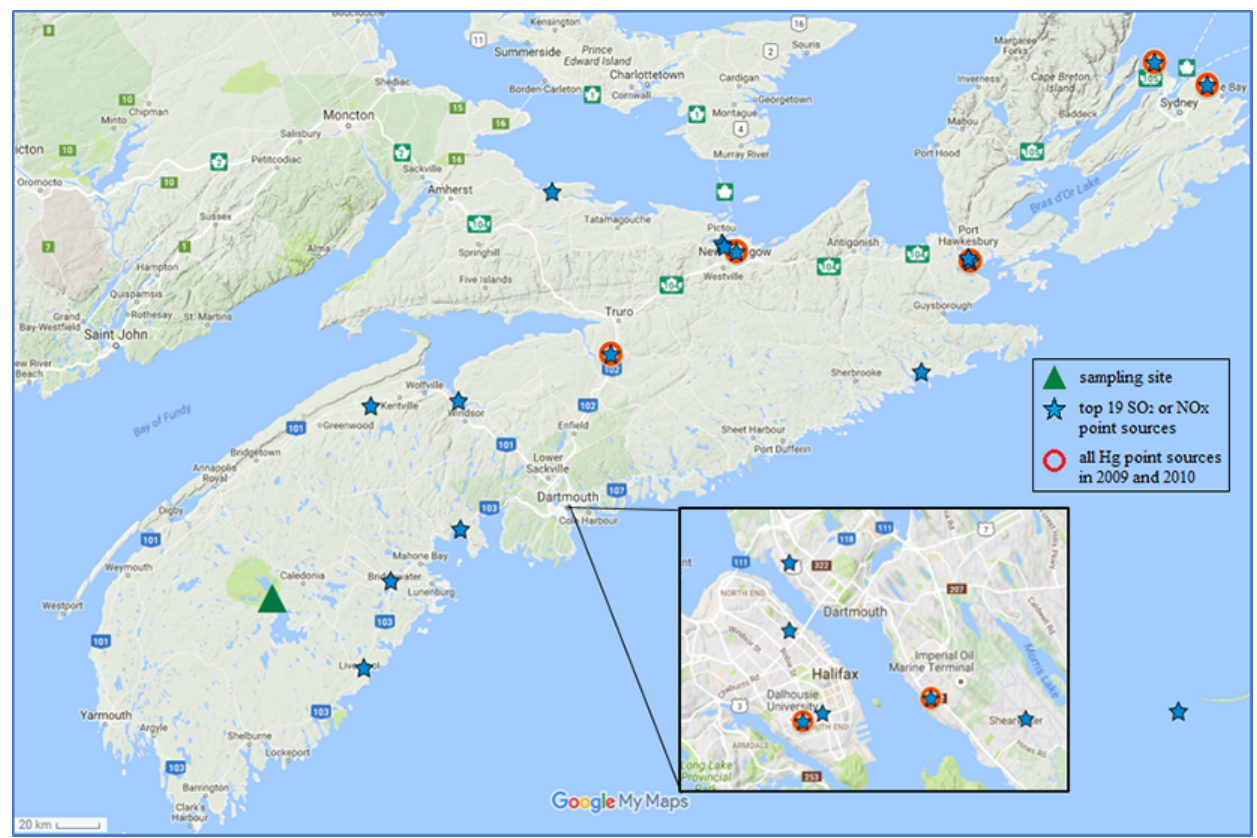
Figure 1. Map showing the locations of sampling site (green (cid:78) ), the top 19 SO 2 or NO x point sources (average of 2009 and 2010) (blue (cid:70) ), and all Hg point sources in 2009 and 2010 (red (cid:13) ), in Nova Scotia, Canada.